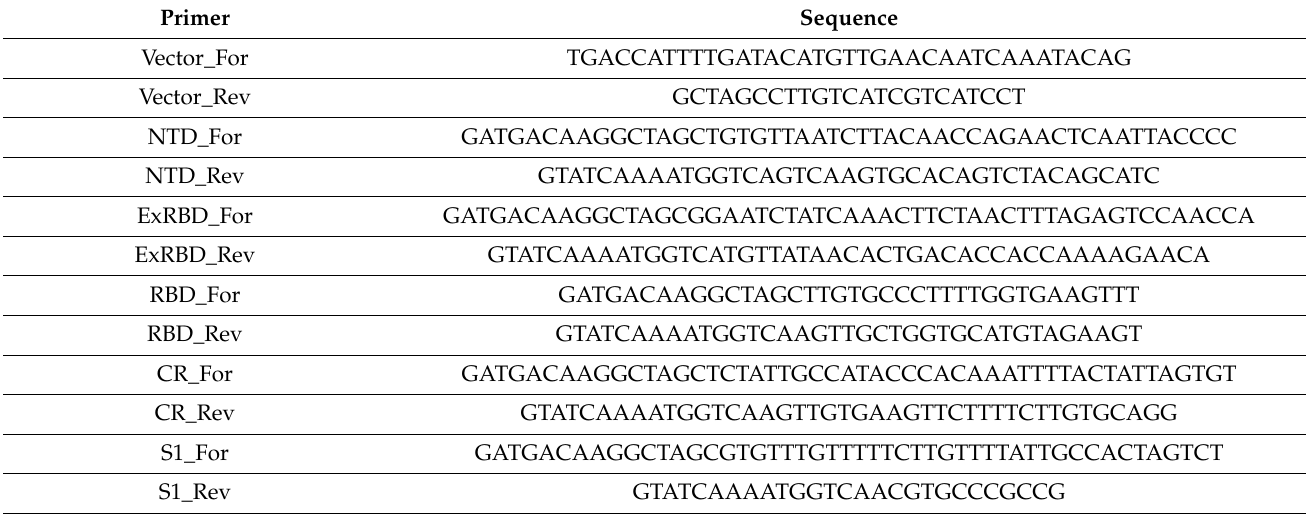
Table 1. Primers used to produce pT7/NSP3-2A-CoV2